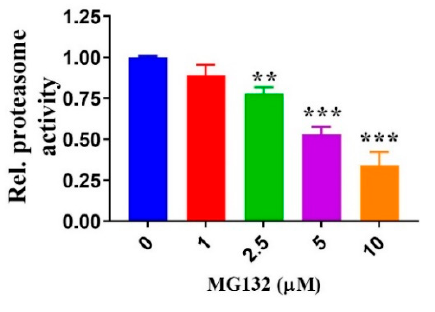
( C ) Figure 5. Effect of oxidants on lysosomal pH and proteasome activity. ( A ) Measurement of intra-lysosomal pH using Ly- soSensor™ Yellow/Blue DND-160 in ARPE-19 cells plated in 96-well plates and incubated with HQ or H 2 O 2 for 2 h. ( B , C ) Proteasome activity using a fluorogenic substrate for detection of chymotrypsin-like activity in cells treated with HQ or H 2 O 2 for 2 h. Data represent the mean + SD of 3 independent experiments of 3 replicates each. Statistical analysis using one-way ANOVA followed by Dunnett’s multiple comparison test. ** p < 0.01, *** p < 0.001, significant difference relative